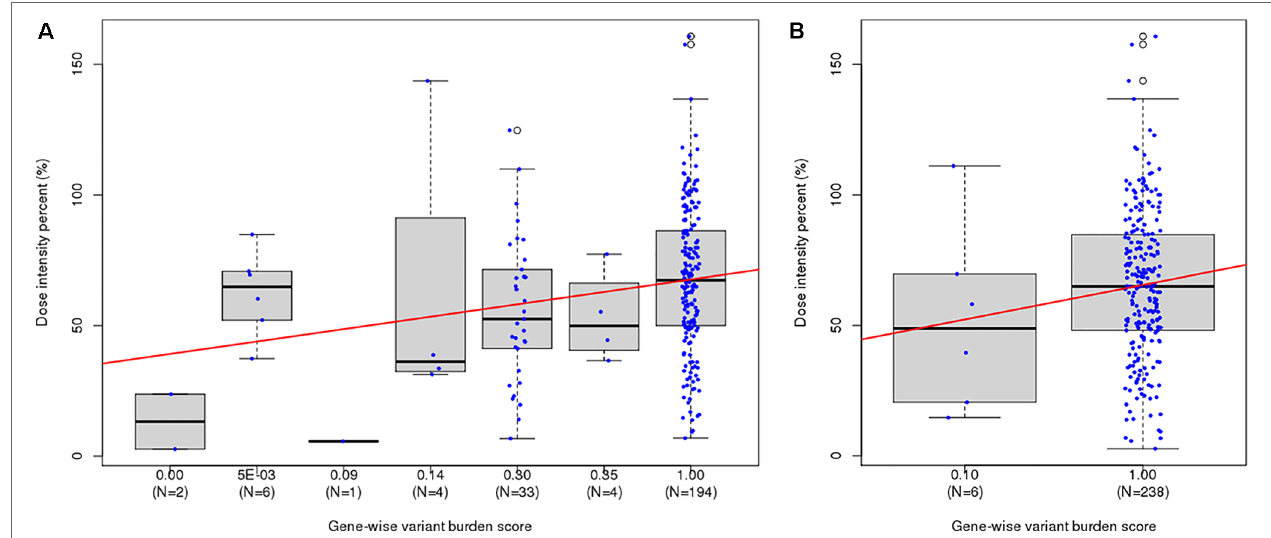
FIGURE 3 | Distribution of last-cycle dose intensity percent of 6-mercaptopurine according to gene-wise variant burden (GVB) score bins. (A) GVB NUDT15 [Kruskal– Wallis p -value = 0.016, Spearman’s rank correlation p -value = 0.001 ( ρ = 0.21), and Kendall’s rank correlation p -value = 0.001 ( 𝜏 = 0.17)]. (B) GVB TPMT [Kruskal– Wallis p -value = 0.271, Spearman’s rank correlation p -value = 0.272 ( ρ = 0.07), and Kendall’s rank correlation p -value = 0.271 ( 𝜏 =